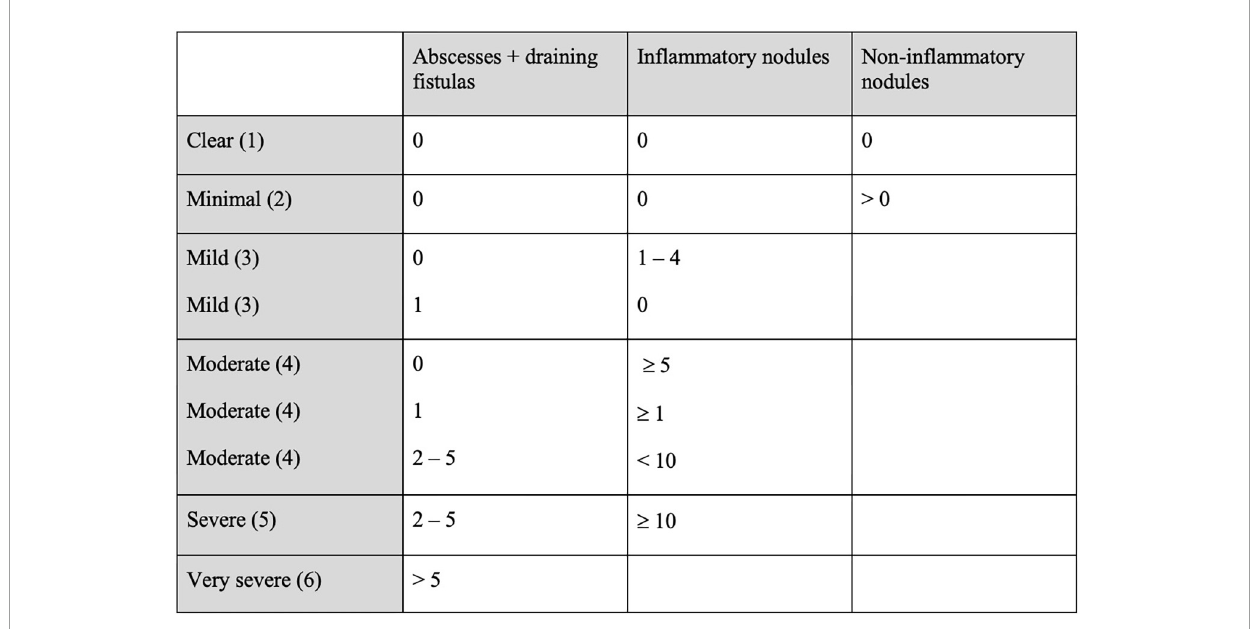
FIGURE5 Hidradenitis Suppurativa Physician’s Global Assessment (HS-PGA, PGA)